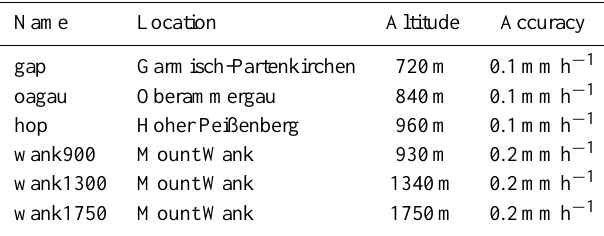
Altitude Frequency